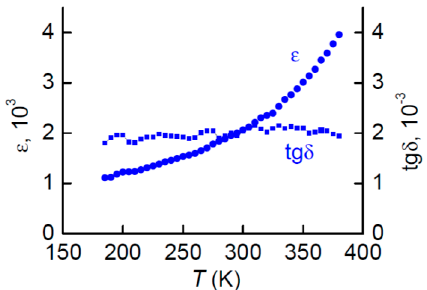
Figure 4. Temperature dependences of the relative dielectric permittivity and dielectric losses for the lead zirconate titanate (PZT) material.